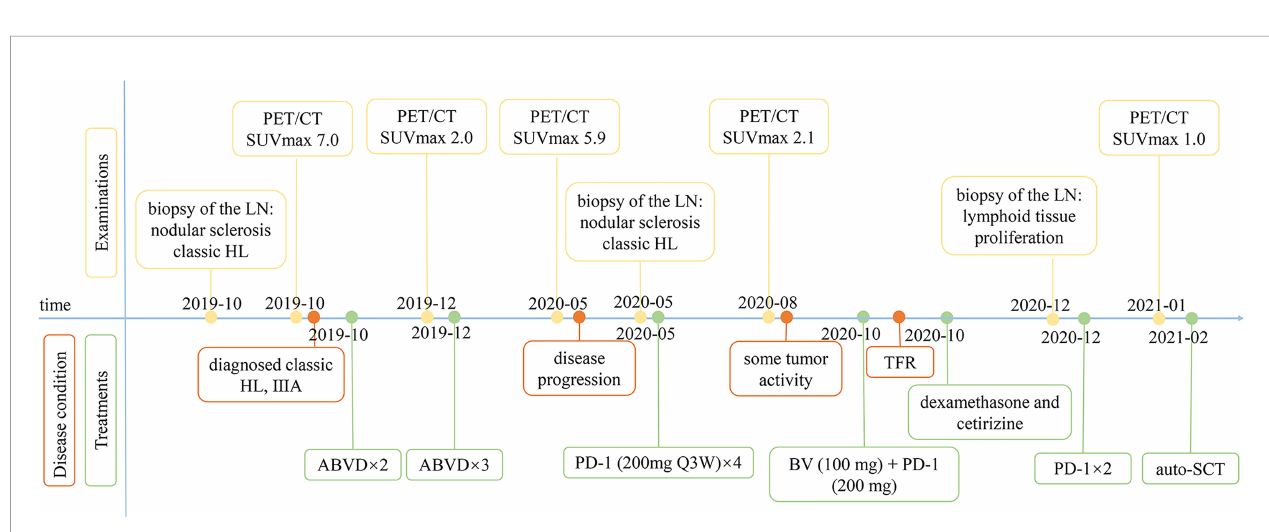
FIGURE 3 | Changes of lymph nodes evaluated by CT. (A) In September 2020. (B) In October 2020. (C) In December